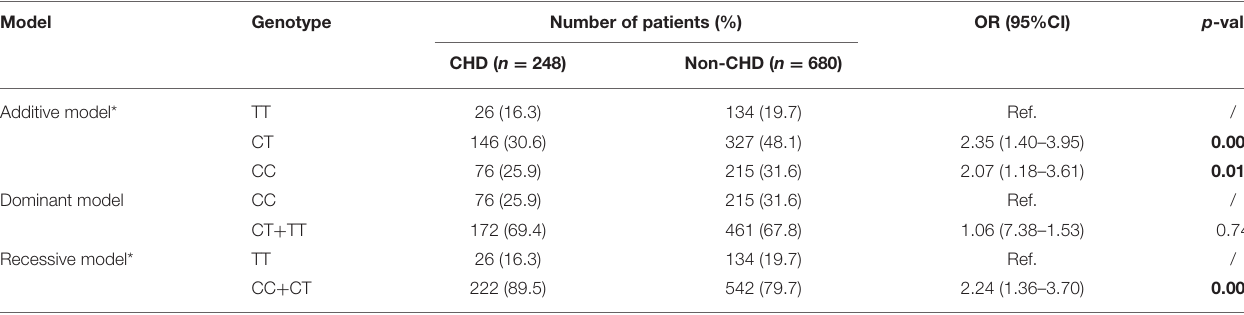
TABLE 3 | The association between rs1800504 and the risk of CHD in T2DM patients.